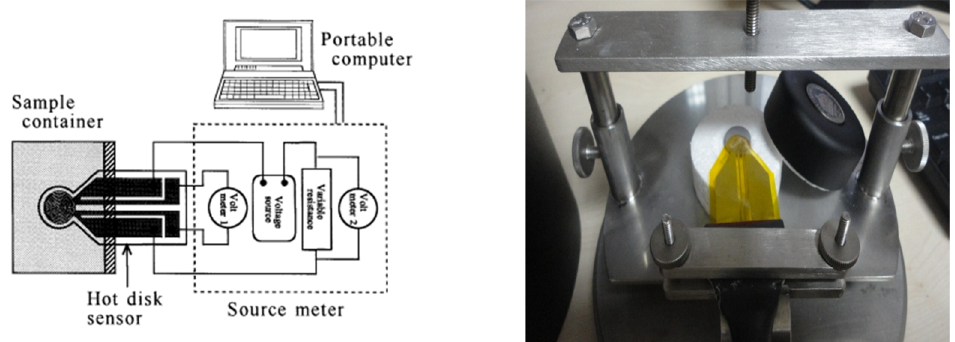
Figure 2: Schematic diagram of the hot - disk method.